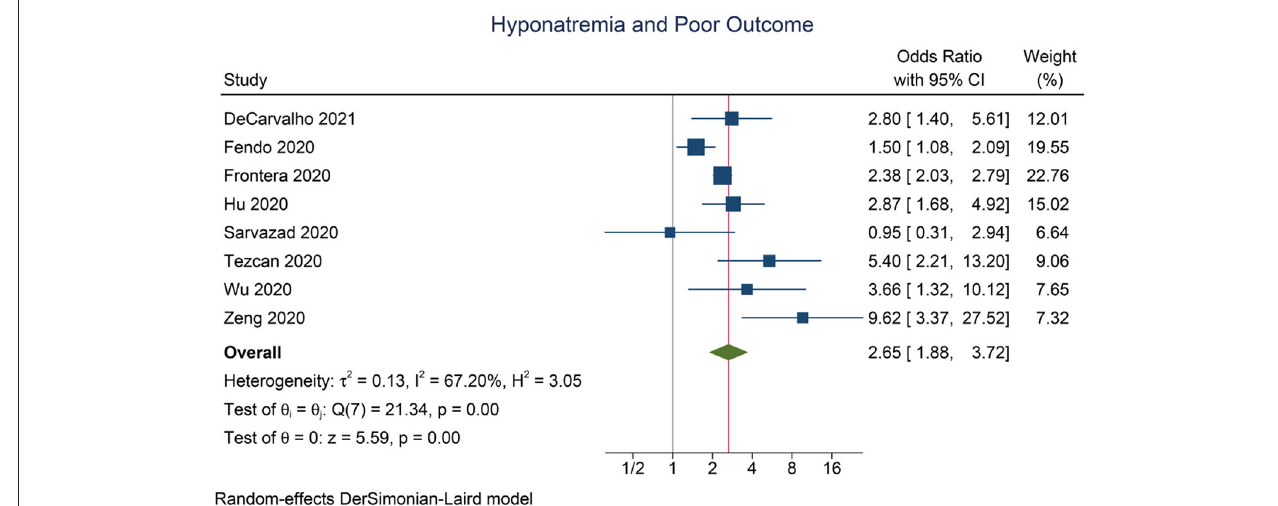
FIGURE 2 | Hyponatremia and poor outcome.